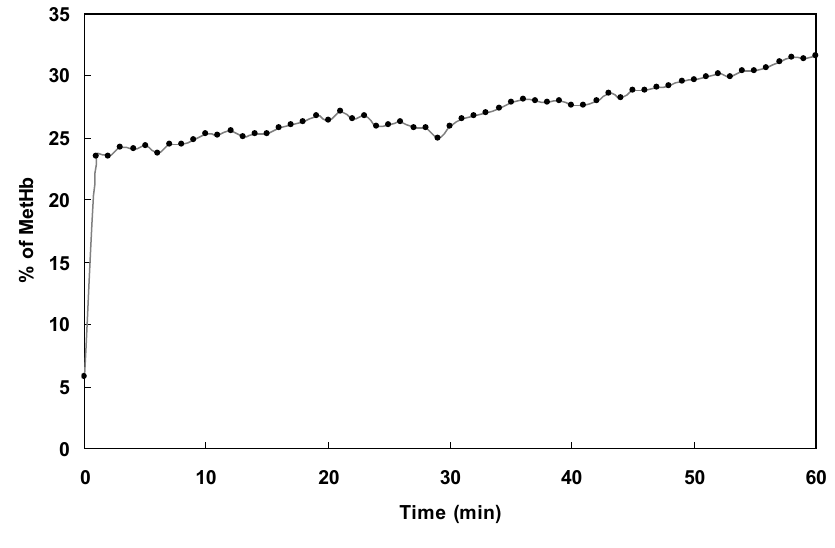
Figure 2. Time scan determination of methemoglobin (%) determined after addition of 300 mL of dust supernatant determined in hemoglobin solution with about 2-3 mg/mL protein in 0.1 M phosphate buffer pH 7